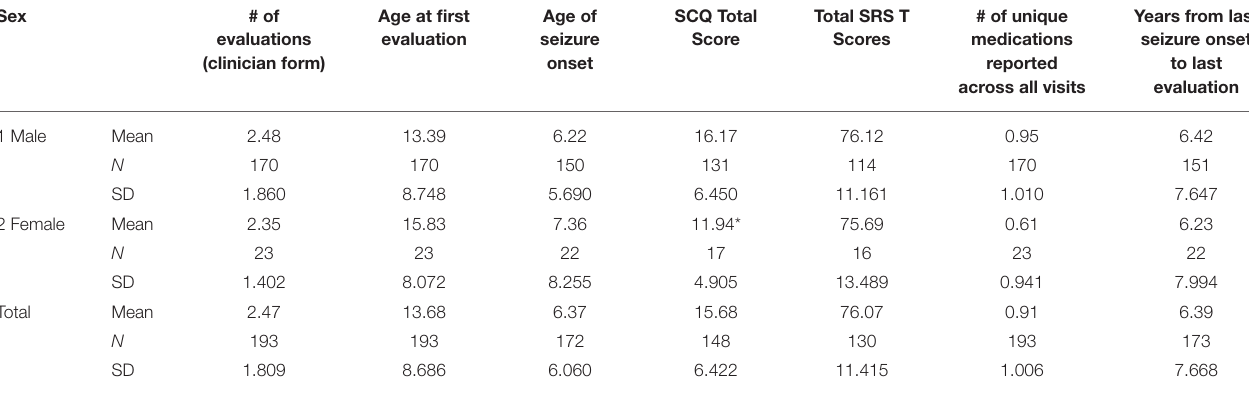
TABLE 3 | Characteristics of the FXS FORWARD participants with